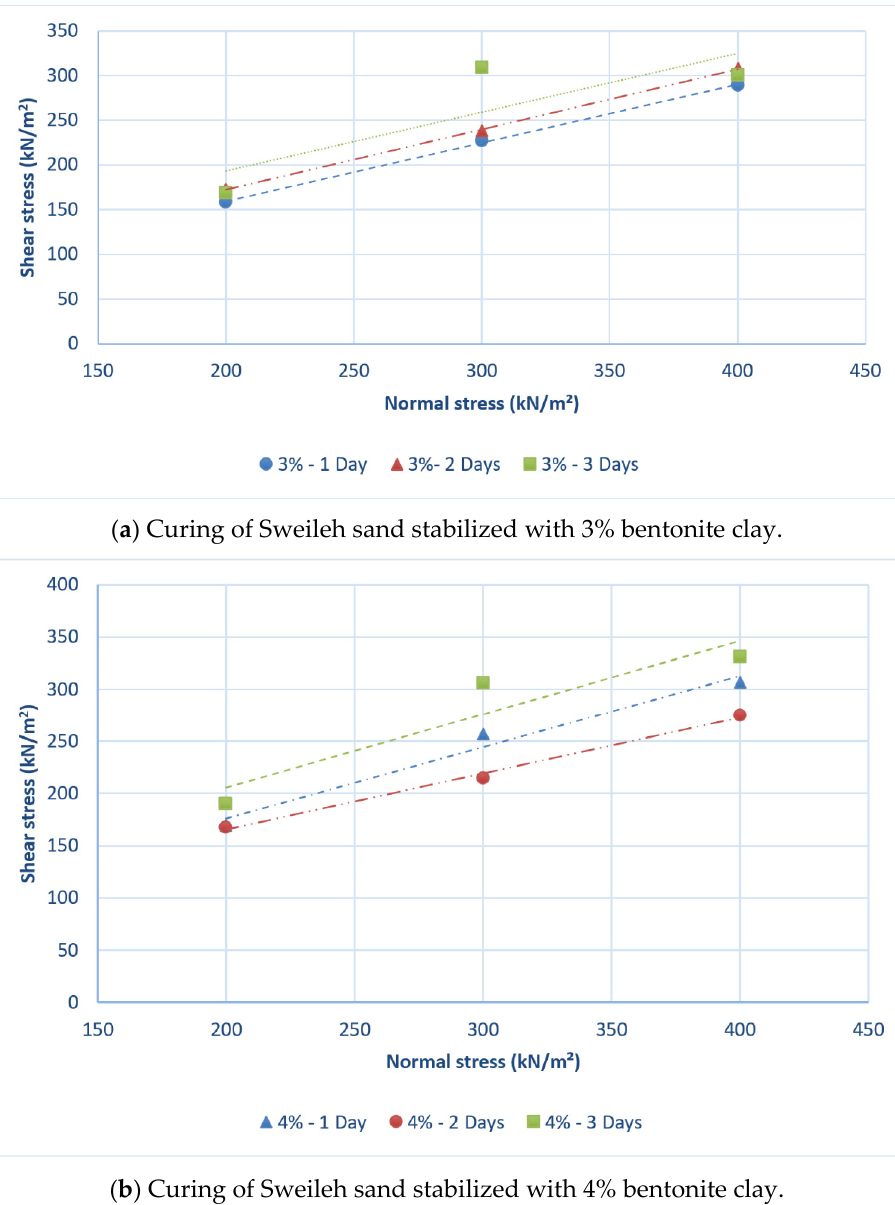
Figure 10. Shear failure envelopes after curing for Sweileh soil using: ( a ) 3% bentonite clay; ( b ) 4% bentonite clay.